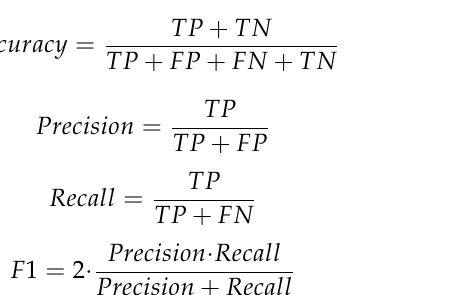
Table 1. Neural network learning results.